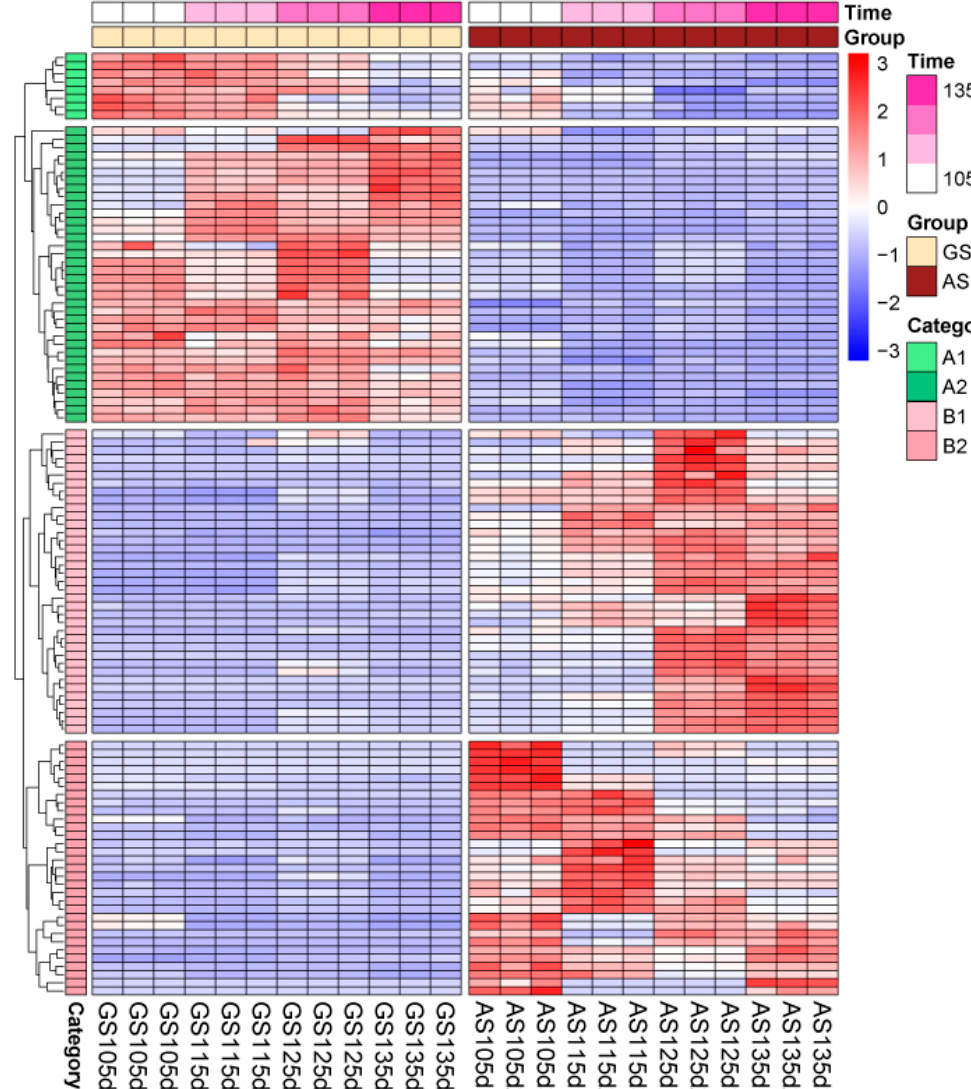
Figure 3. Based on the cluster result, all the DEMs were classified into two major categories. Forty- four lower content or down-regulated accumulative metabolites were clustered into category (A), whereas 68 metabolites which showed the opposite trend were clustered into category (B). Further, both categories (A) and (B) were divided into two subcategories.